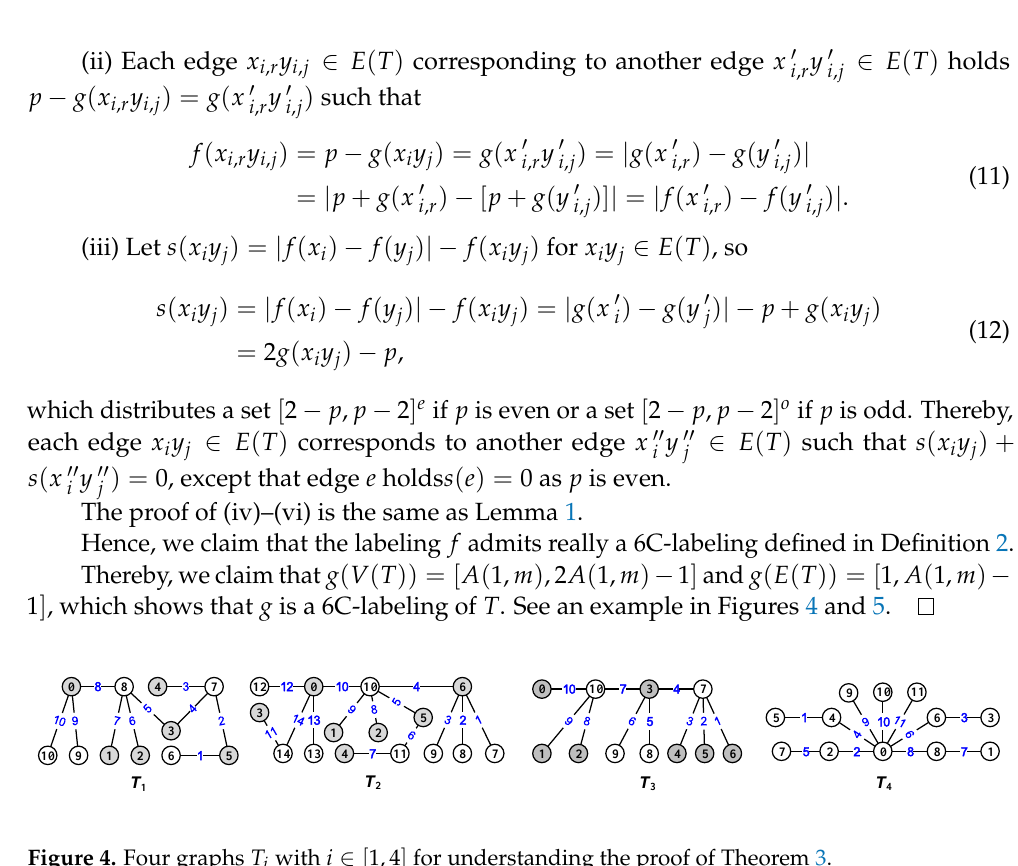
Figure 4. Four graphs T i with i ∈ [ 1,4 ] for understanding the proof of Theorem 3.